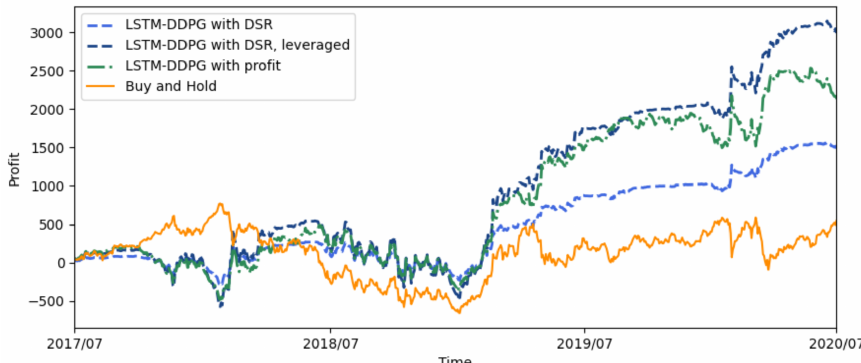
Figure 3. The profit curves of LSTM-DDPG with different reward